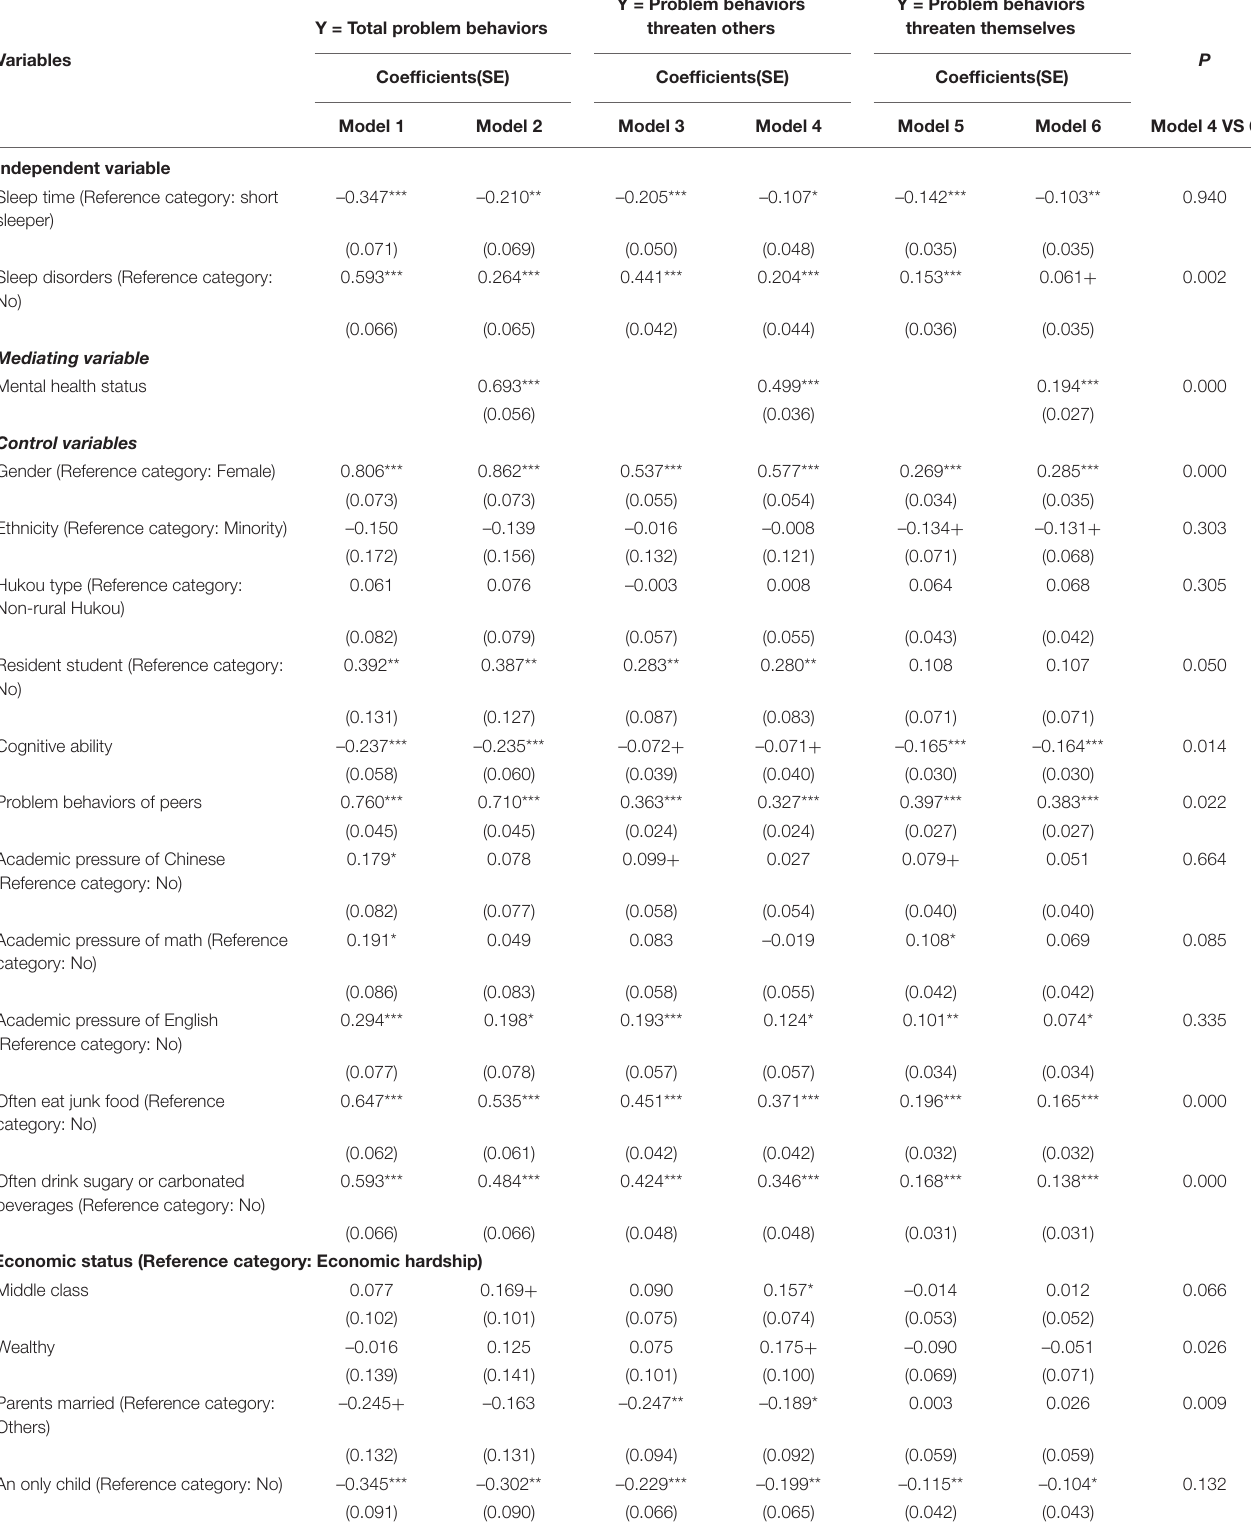
TABLE 2 | OLS results before and after adding the mental health